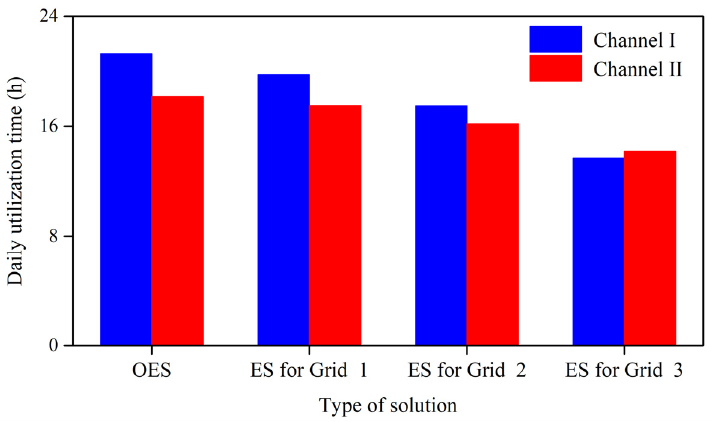
Figure 8. Daily utilization time derived from one optimal equilibrium solution (OES) and three extreme solutions (ES) of Channels I and II connecting YnPG with GdPG and GxPG, respectively.